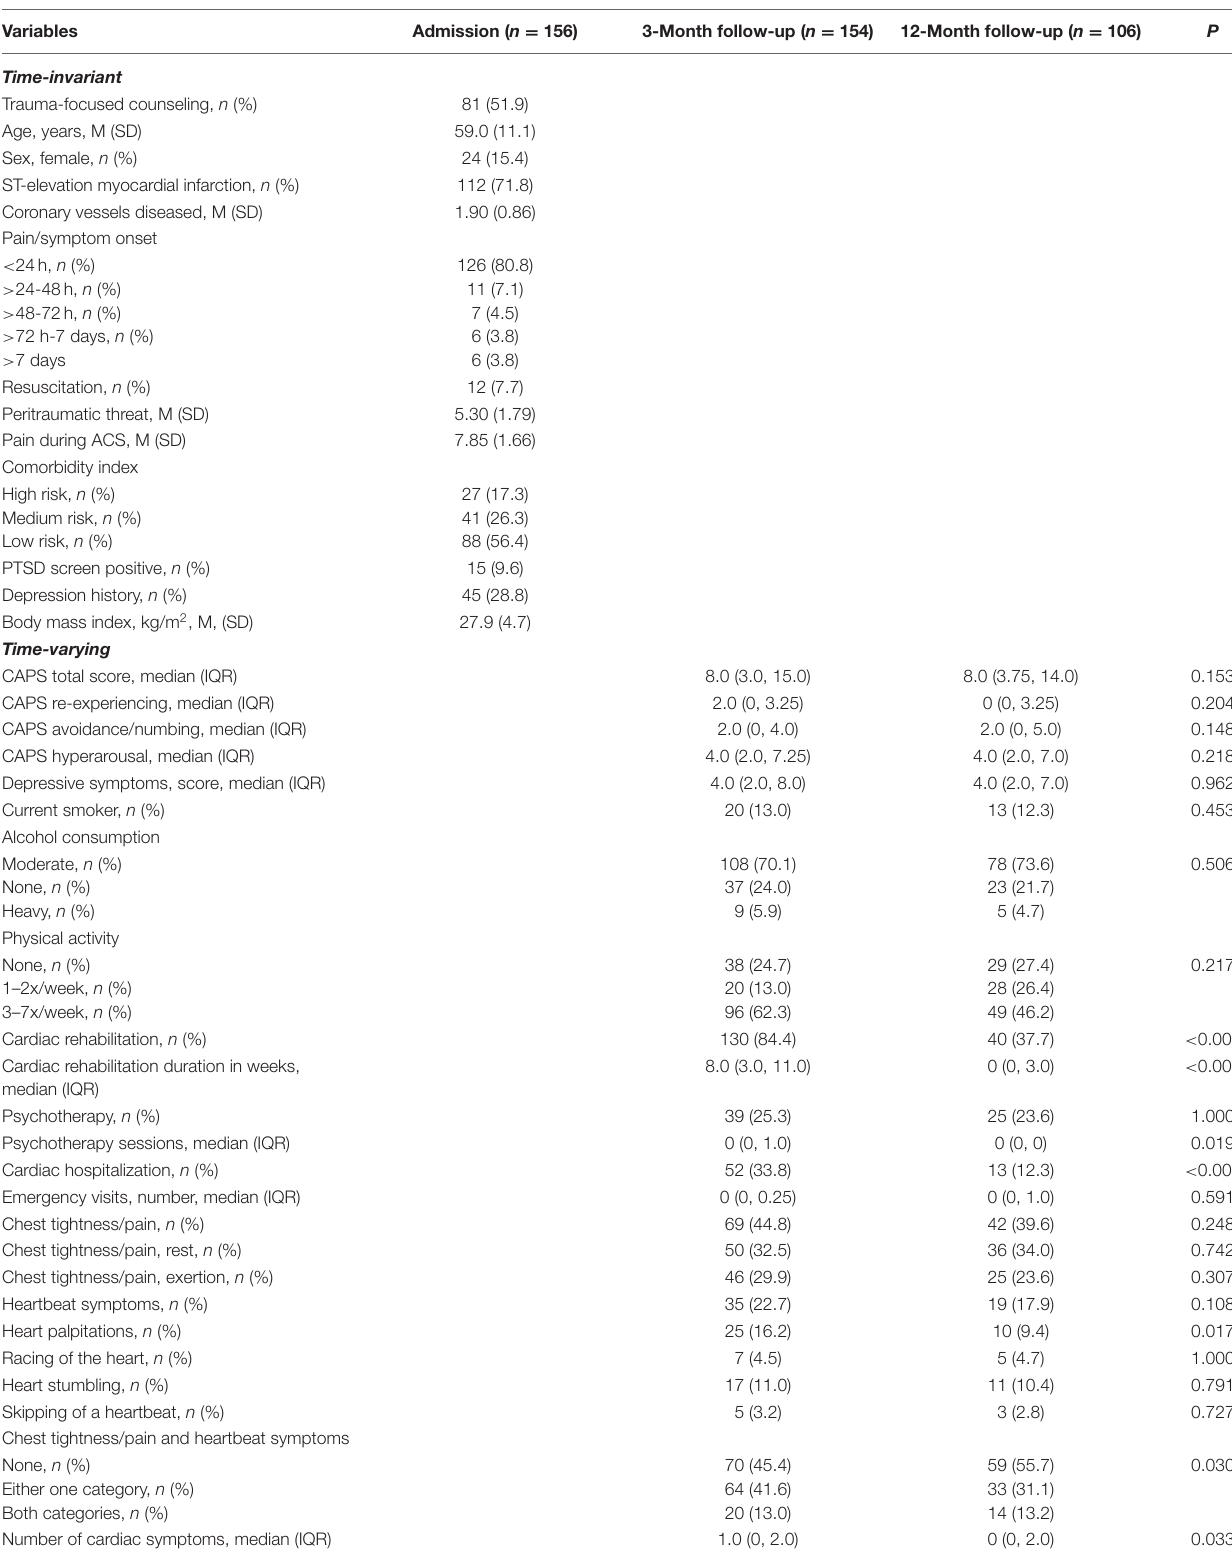
TABLE 1 | Characteristics of study participants at hospital admission and at the two